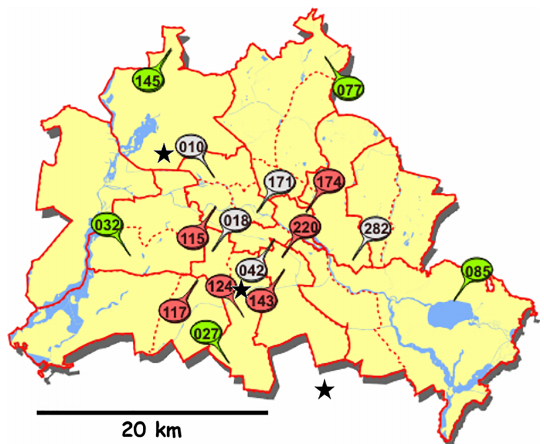
Figure 1. The 16 automated air quality stations of the BLUME net- work. Ceilometer measurements reported in this paper were con- ducted at station 42, one of the urban background sites (in grey). Traffic stations are shown in red. The green flags are stations at the outskirts of Berlin and in forests (rural background). More details are given in Table1. The three black stars indicate the wind mea- surements in Tegel, Tempelhof and Schönefeld (from northwest to southeast) mentioned in Sect. 5.1. Adaptation of a figure of the Sen- ate of